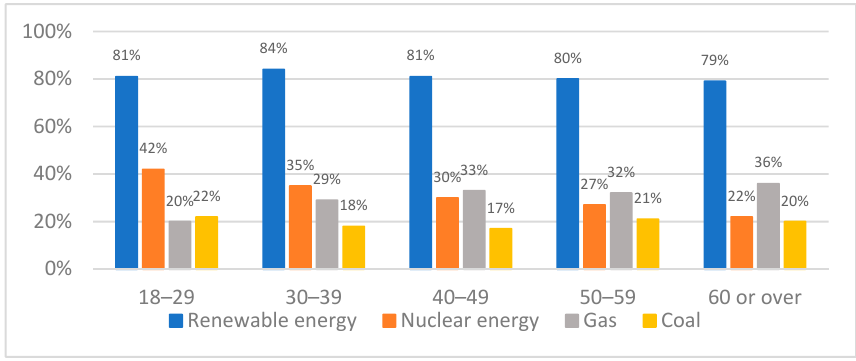
Figure 6. Preferred energy sources by consumers (by age) in which Poland should invest. The analytical and prognostic part of this study was performed on the basis of ENTSO-E data collected from the cire.pl website. This data represents a time series of aggregated daily electricity consumption expressed in Gigawatt hours (Gwh). The range of the data covers the dates from 31 December 2014 to 30 June 2021 (Figure 7).